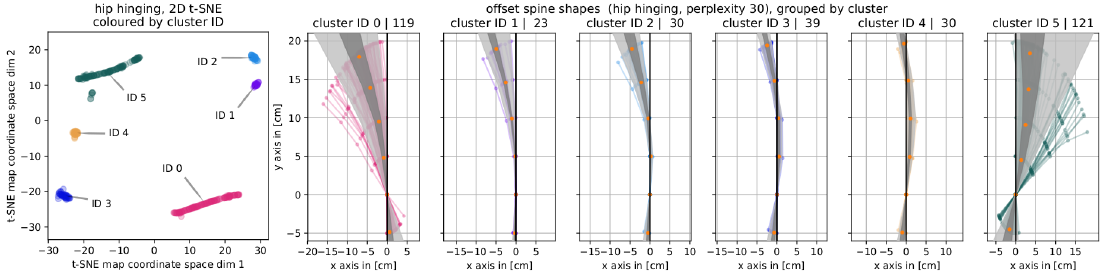
Figure 9. Results for clustering posture pairs of hip hinging . ( left ) The t-SNE map labelled with and colored by cluster ID. ( right ) Corresponding cluster bundles of offset spine shapes